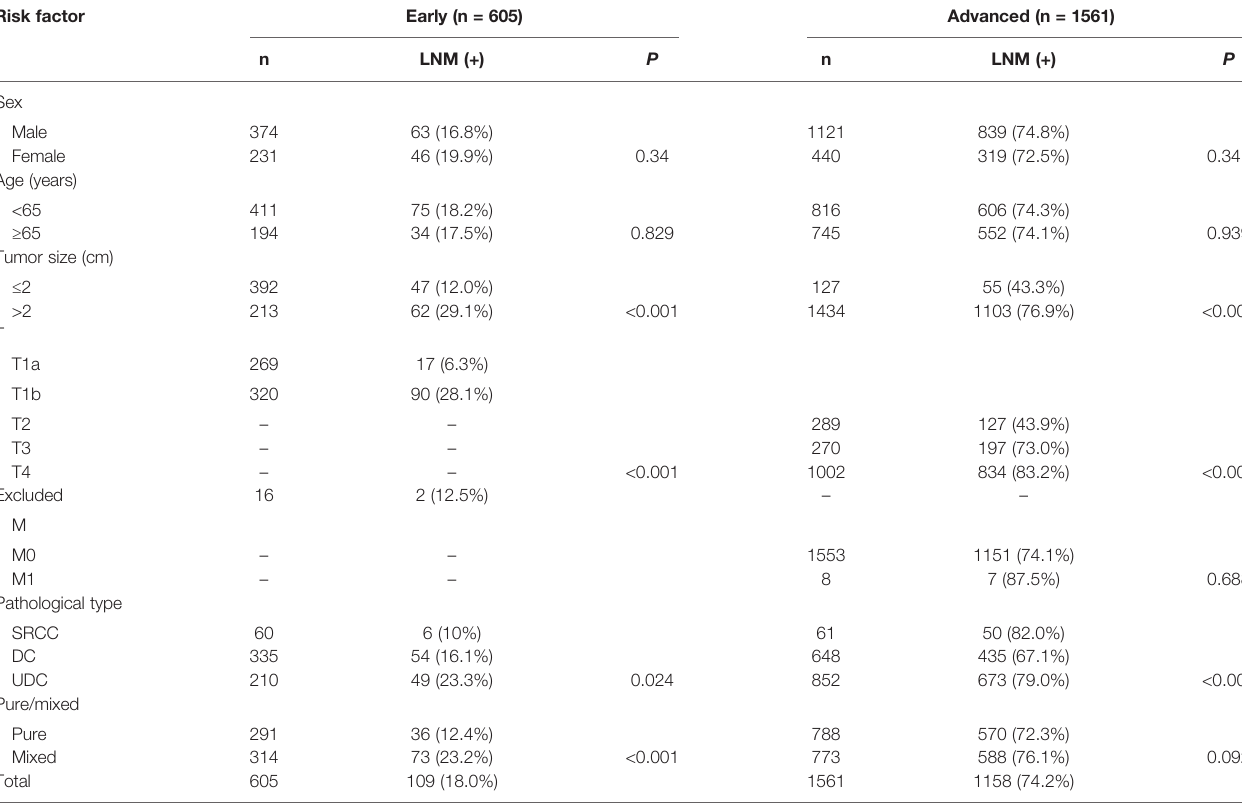
TABLE 1 | Univariate analysis of the risk factors for lymph node metastasis in early and advanced gastric cancer.